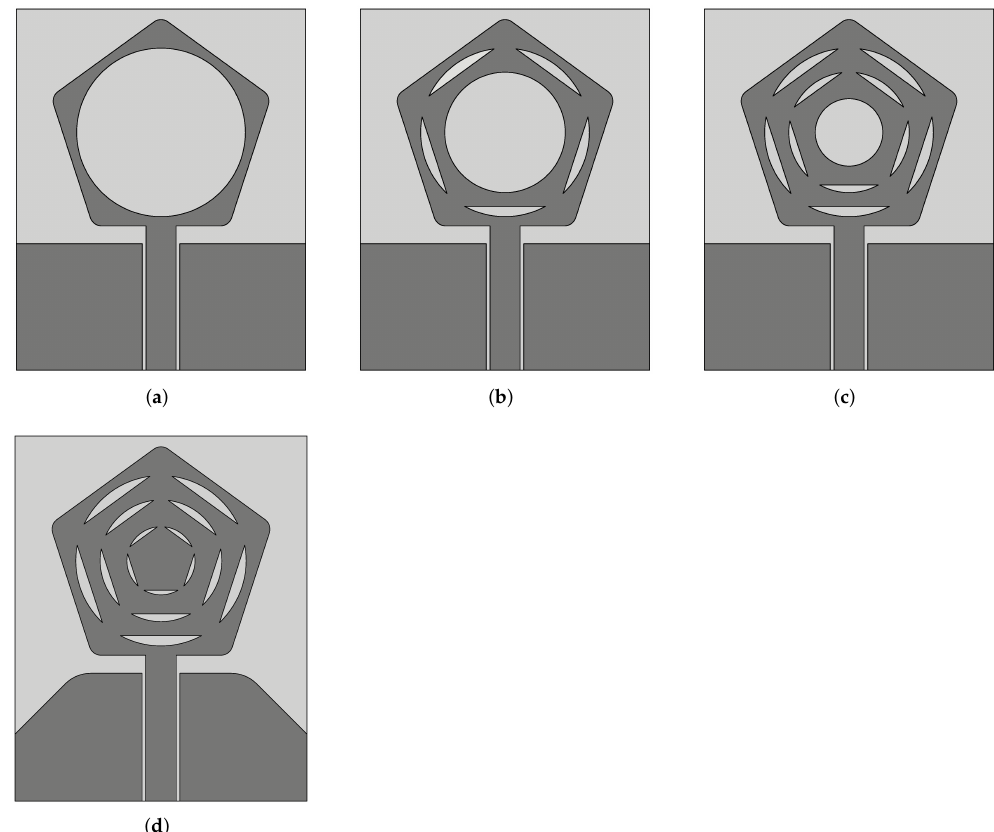
Figure 3. Design evolution of the proposed CPW-fed pentagonal fractal antenna ( a ) Step 1, ( b ) Step 2, ( c ) Step 3, and ( d ) Step 4